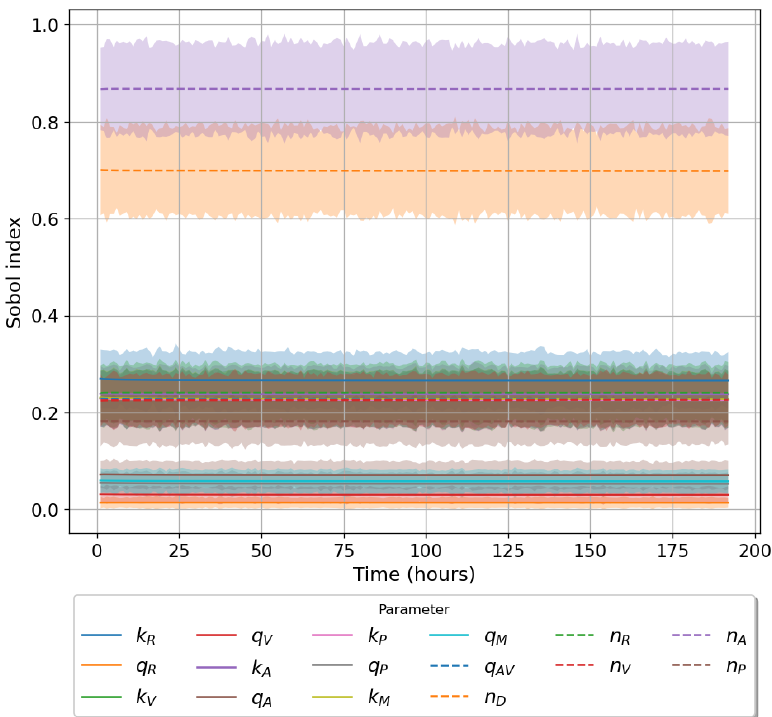
Figure 6. Time evolution of total order Sobol sensitivity indices (model 3). Model output for this model is phosphorylated PKR, n AD . Shaded region accounts for a 95% confidence interval.